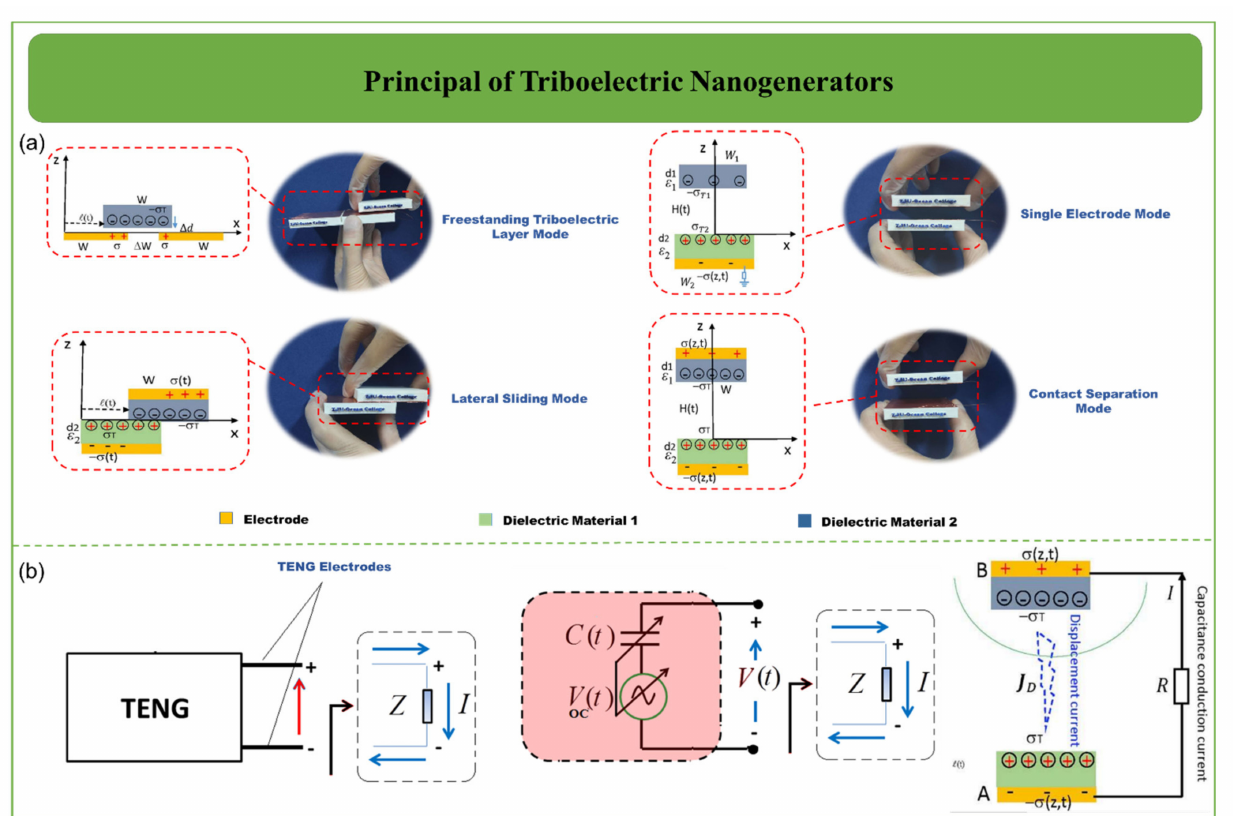
Figure 2. ( a ) The four primary modes of operation for triboelectric nanogenerators include contact sep- aration mode, lateral sliding mode, single-electrode mode, and freestanding triboelectric layer mode. ( b ) Illustration of charge transfer through an external circuit for triboelectric nanogenerators